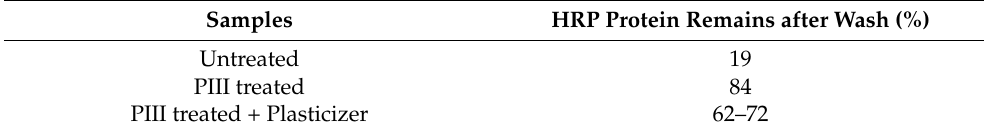
Table 11. Protein attachment on UHMWPE with or without additives